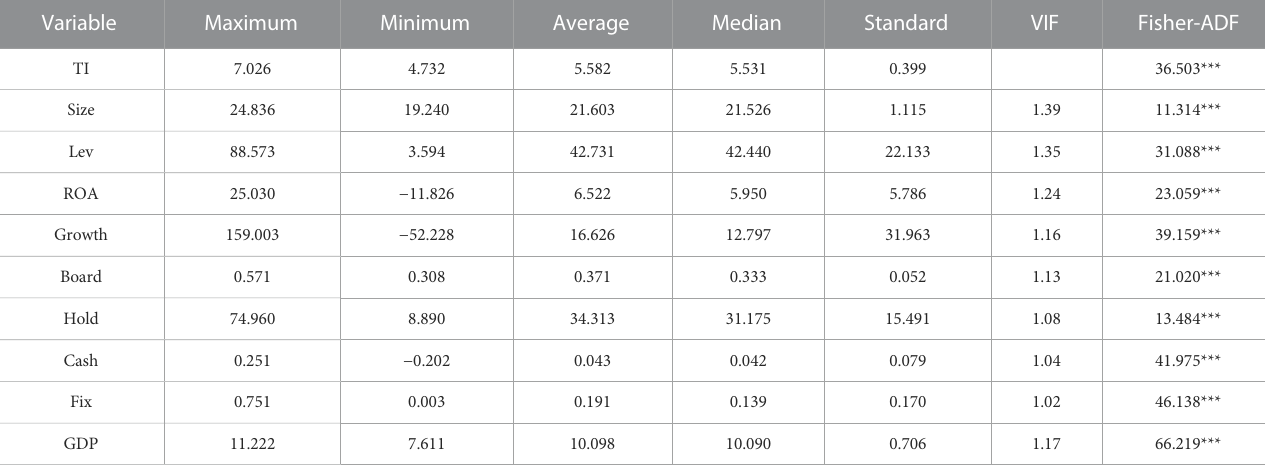
TABLE 2 Descriptive statistical results from 2008 to 2015.